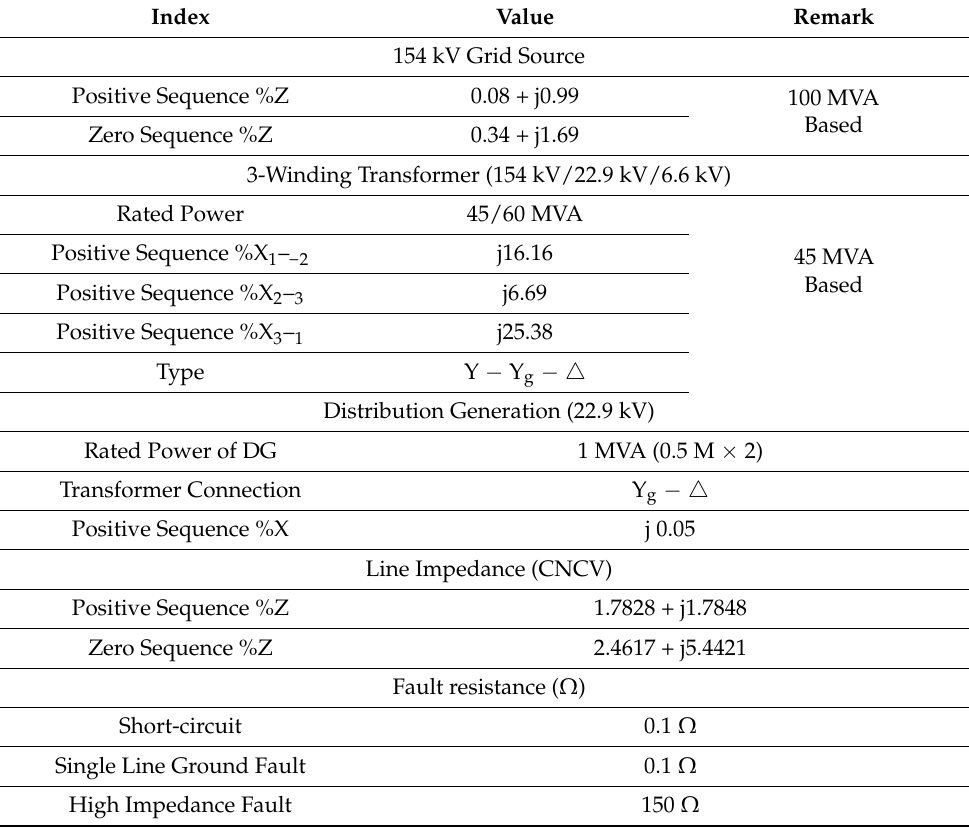
Figure 10. Configuration diagram of loop distribution system. Table 1. Specifications of the system model